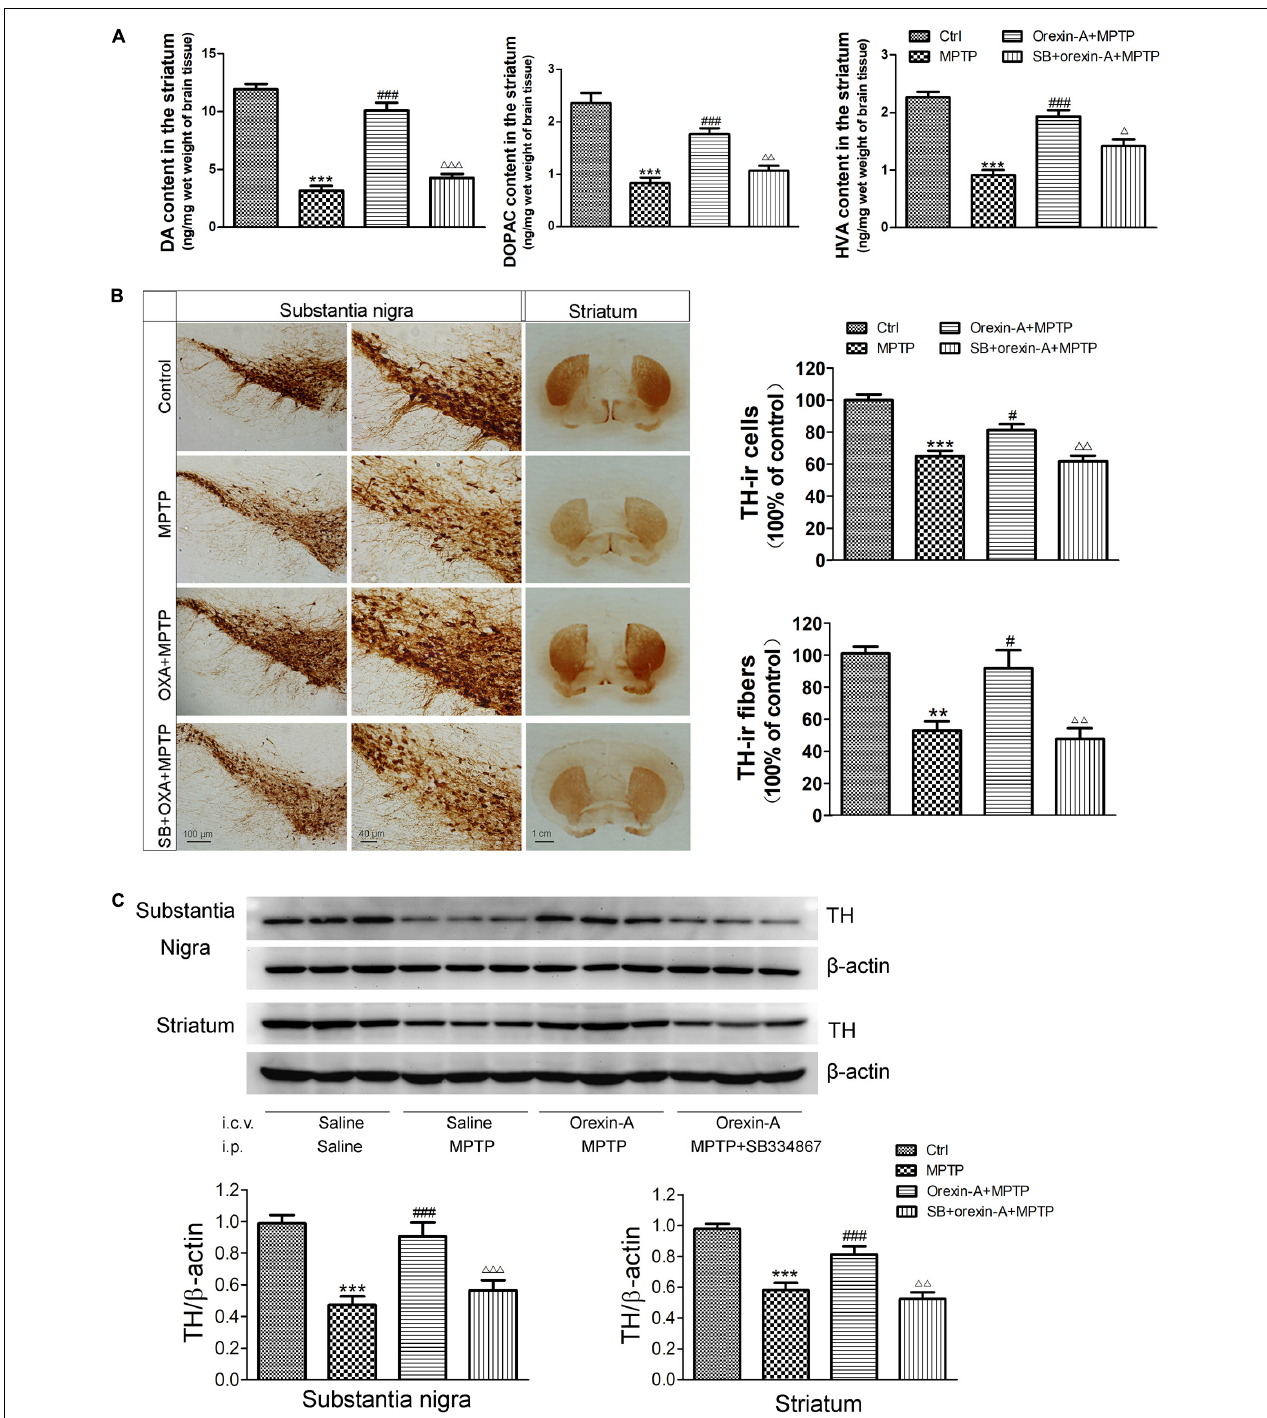
FIGURE 5 | Effects of orexin-A on DA levels and TH protein levels in the substantia nigra and striatum of MPTP-intoxicated mice. (A) HPLC analysis showing the striatal DA, DOPAC, and HVA levels in different groups ( n = 6). (B) Immunohistochemistry showing the dopaminergic neurons in the substantia nigra and the dopaminergic fibers in the striatum of different groups. Photomicrographs of representative substantia nigra and striatal sections stained with TH antibodies. Quantitative analysis of TH-ir neurons in the substantia nigra ( n = 6) and TH-ir fibers in the striatum ( n = 4). (C) Immunoblot analysis showing the TH protein levels in the substantia nigra and striatum of different groups. Average protein level was quantified as ratios between TH and β -actin ( n = 6). ∗∗ P < 0.01, ∗∗∗ P < 0.001 vs. control; # P < 0.05, ### P < 0.001 vs. MPTP; (cid:49) P < 0.05, (cid:49)(cid:49) P < 0.01, (cid:49)(cid:49)(cid:49) P < 0.001 vs. orexin-A + MPTP. OXA: orexin-A, SB: SB334867.